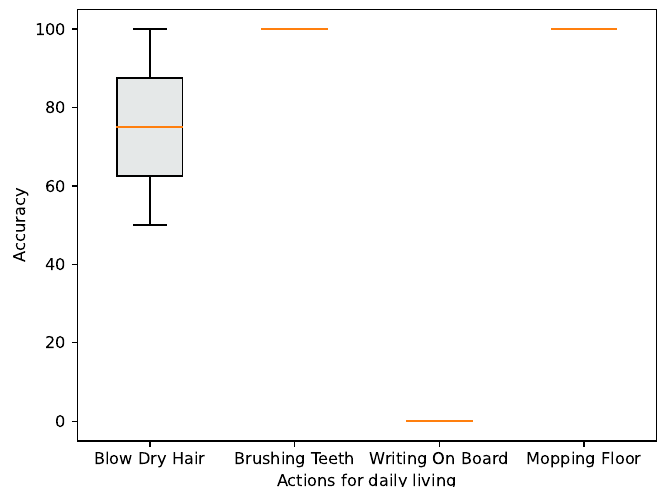
Figure 11. Results for patient UAH-3 based on LOLA’s actions monitoring